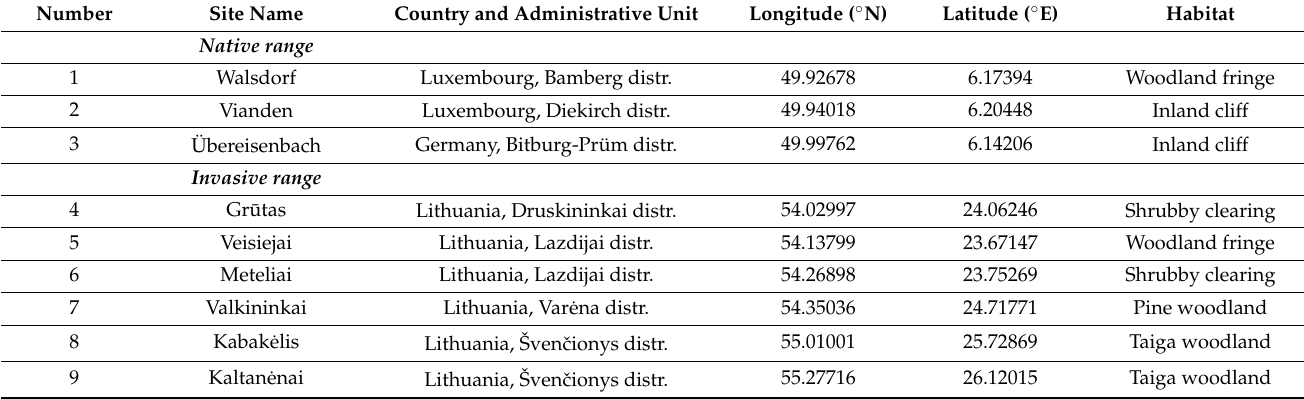
Table 1. Localities and habitats of the sampled Cytisus scoparius populations in the native range in Germany and Luxembourg and in the invasive range in